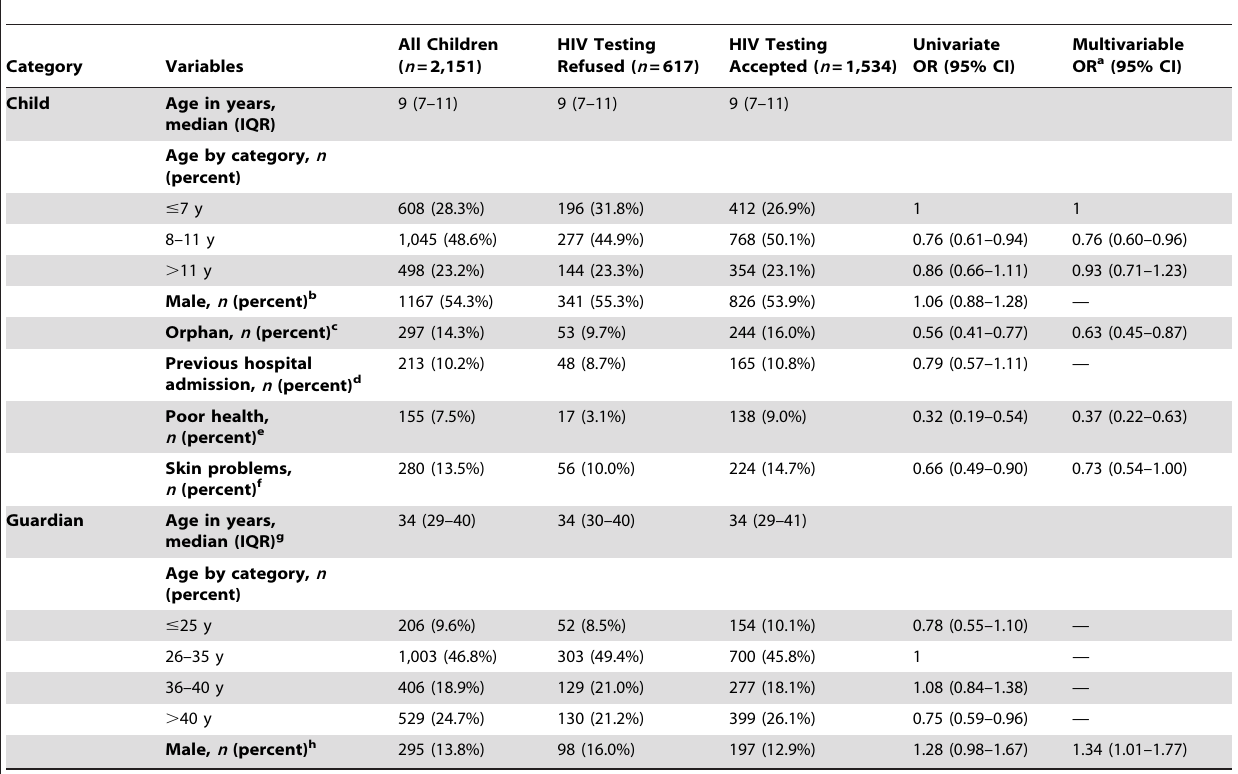
a n =2,061 for the multivariable model. All variables significant at the p =0.1 significance level on univariate analysis were included in the multivariable model (age of child, orphanhood, poor health, skin problems, and sex of guardian). b One missing value. c 73 missing values. d 71 missing values. e 72 missing values. f 73 missing values. g Seven missing values. h 13 missing values. OR, odds